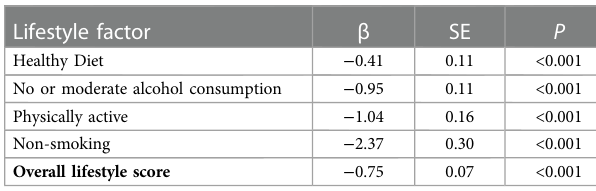
TABLE 3 Association of Δ age with overall lifestyle score and each individual lifestyle